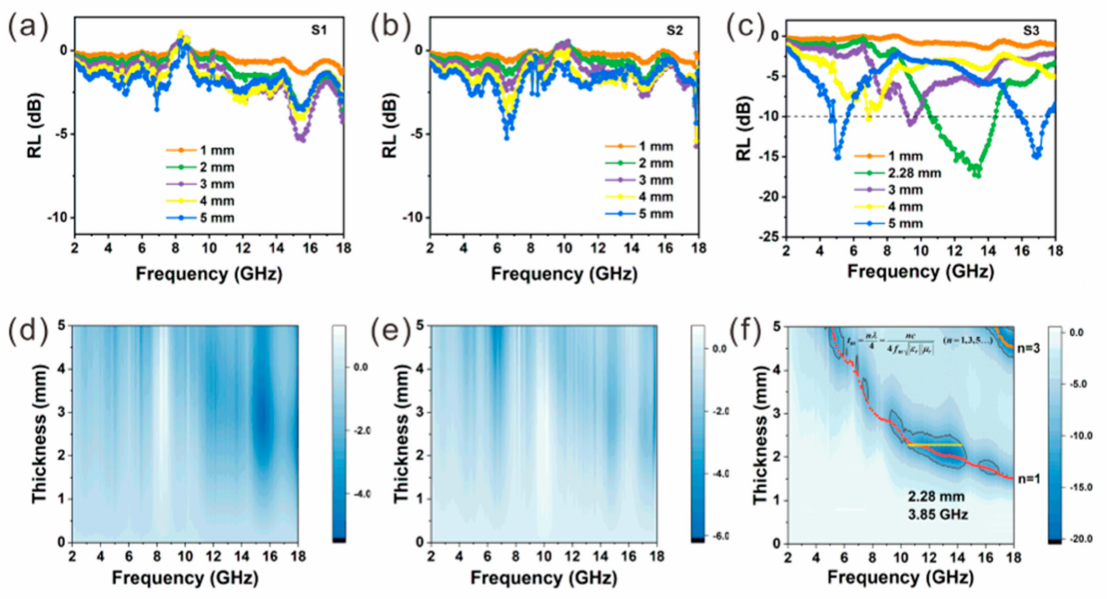
Figure 7. The 1D and 2D diagrams of the RL value changing with frequency and thickness: ( a , d ) S1, ( b , e ) S2 and ( c , f )